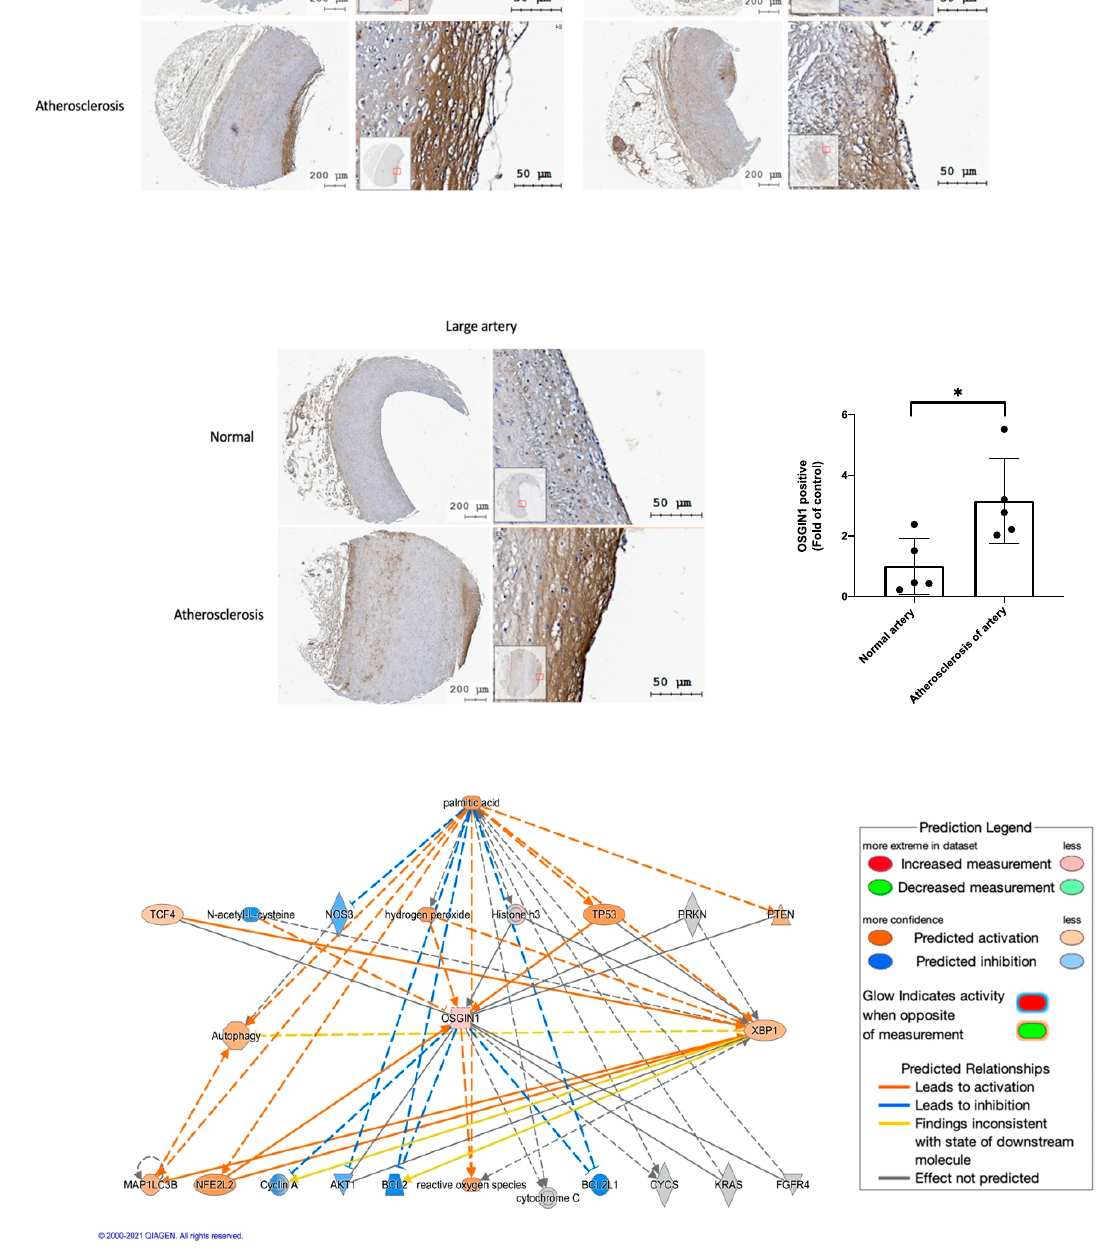
Figure 6. OSGIN1 is involved in atherosclerosis processing: ( A ) The expression of OSGIN1 in human artery tissue microarrays was determined with immunohistochemistry (normal artery n = 5, atherosclerosis artery n = 5, respectively; scale bar: 50 µ m). ( B ) QIAGEN’s Ingenuity Pathway Analysis was used to generate the pathway analysis. Data from two groups were analyzed with two-tailed Student’s t -test. * p < 0.05 compared to control.